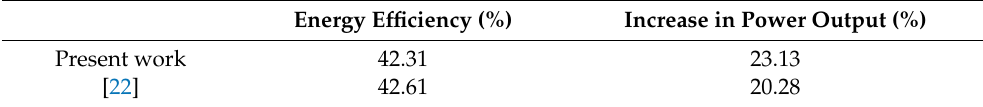
Table 10. Comparison of model results with those of [22].